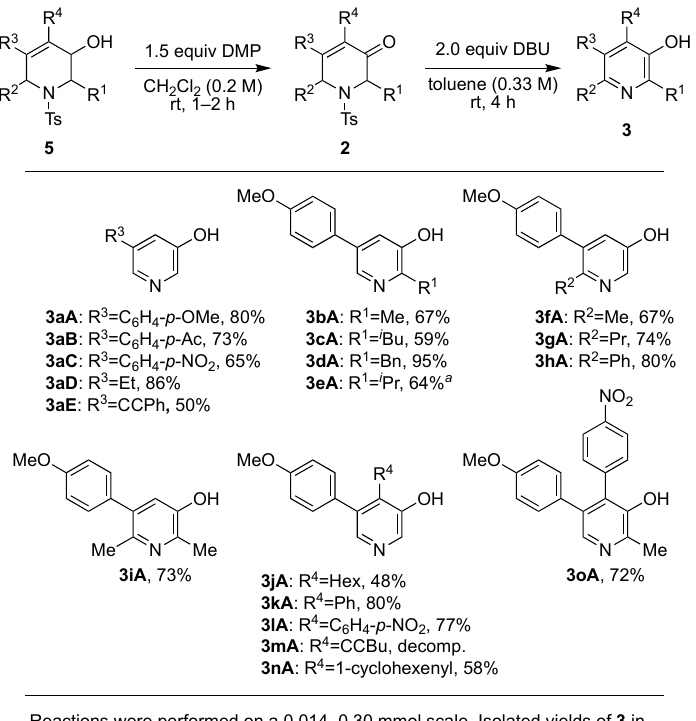
Scheme 5. Conversion of 3-hydroxytetrahydropyridines 5 to 3-hydroxypyridines 3